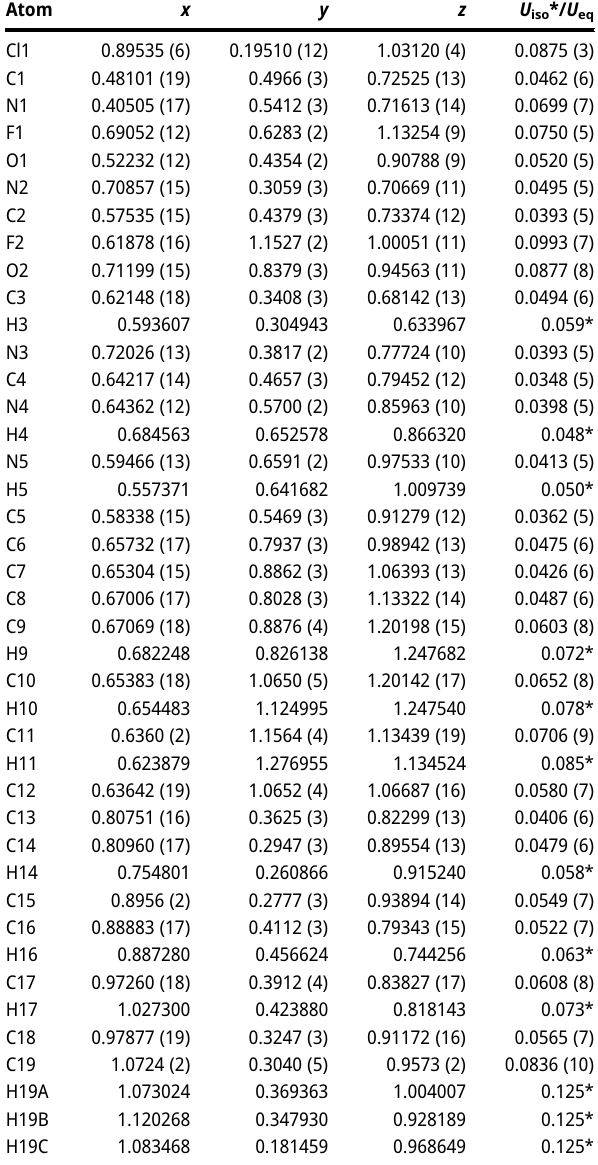
Table  : Fractional atomic coordinates and isotropic or equivalent isotropic displacement parameters (Å 